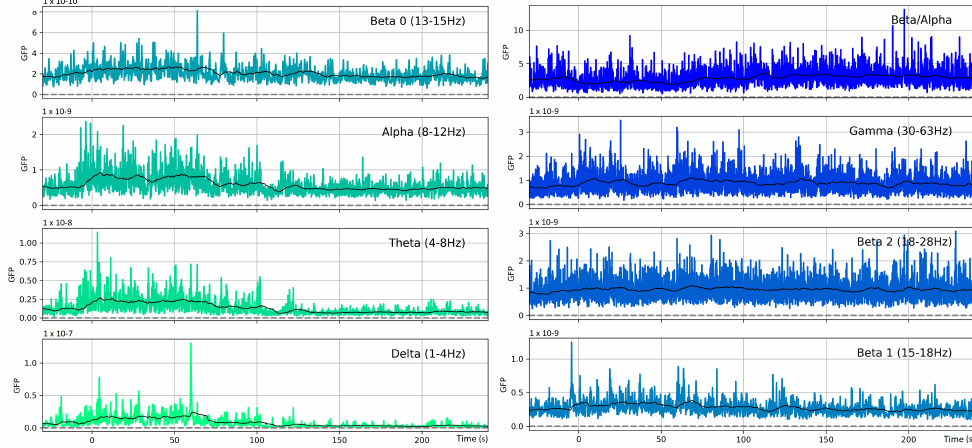
Figure 12. Global Field Power for individual brain waves for participant 1, averaged values for a stressful